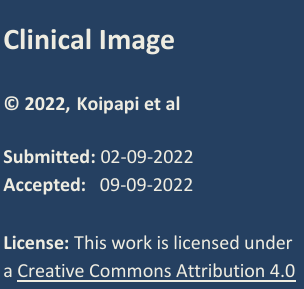
Klinefelter's syndrome which may have dysmorphic features or Karyotype confirmation. Congenital lymphedema without any dysmorphic features and